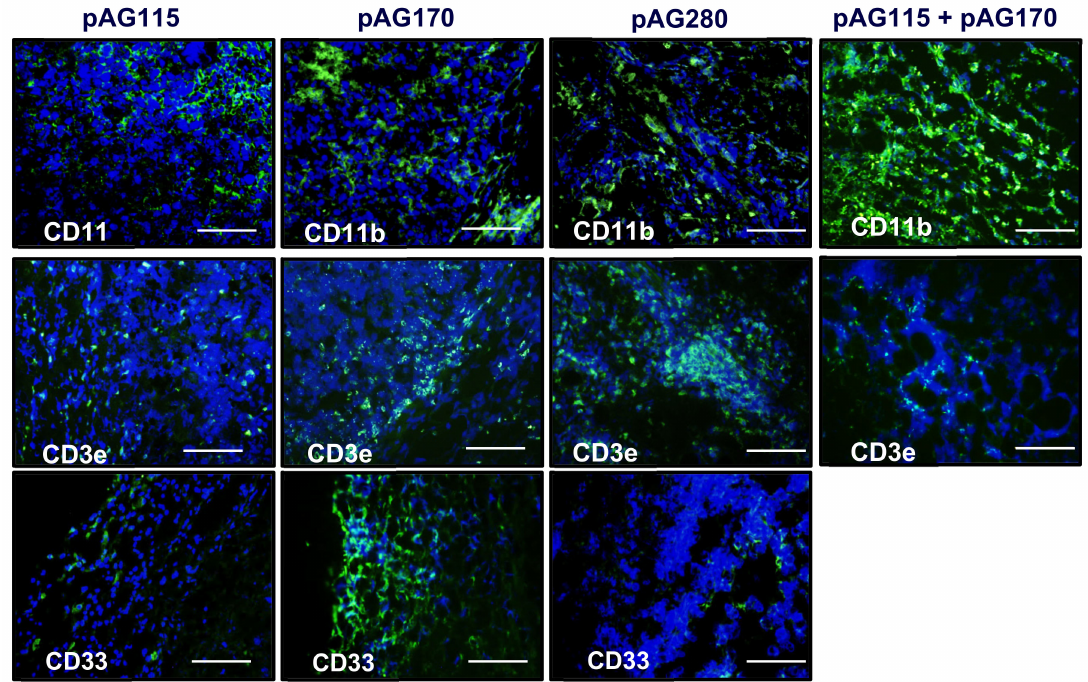
Figure 6. IL-15 GET induces immune cell infiltrate into the tumor microenvironment. Haematoxylin and eosin stain. Anti-CD3e (green-T cells), anti-CD11b (green-APCs), and anti-CD335 (green—natural killer cells) staining (green) reveal the presence of immune cells within the tumors of mice treated using EP2 to deliver pAG115, p,G170, and pAG208 on days 0, 4, and 7. Tissue was collected on day 8 (24 h after the third treatment). Images are the best representative sample of n = 2 for each group. Sections were counterstained with a nuclear dye 4 (cid:48) ,6-diamidino-2-phenylindole (DAPI) (Blue). Mag = 20 × . Scale bar = 500 µ